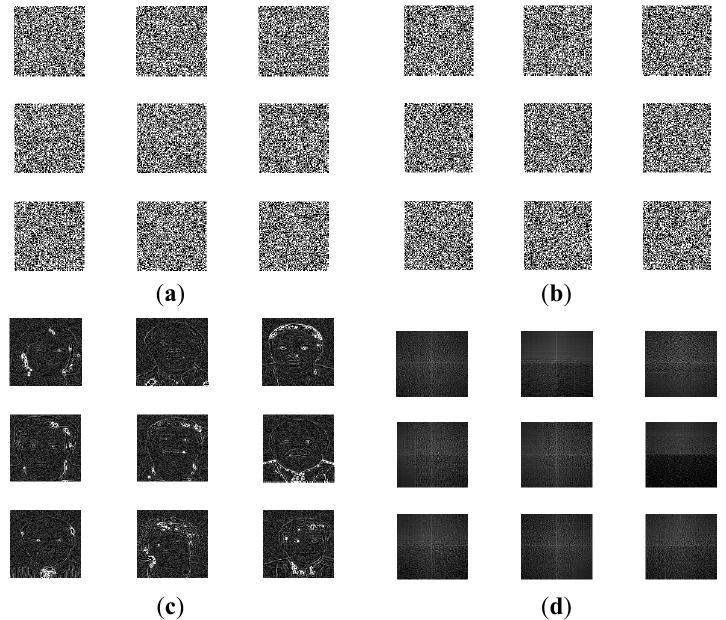
Figure 6. Encrypted versions of biometric faces in Figure 5 (from ORL dataset) for ( a ) CFR1 ( b ) CFR2, ( c ) homomorphic transform followed by salting and ( d ) homomorphic transform followed by random kernel convolution. Figure 14. Sample of greyscale facial images from Labelled Faces in the Wild (LFW) database [27] used as original biometrics.